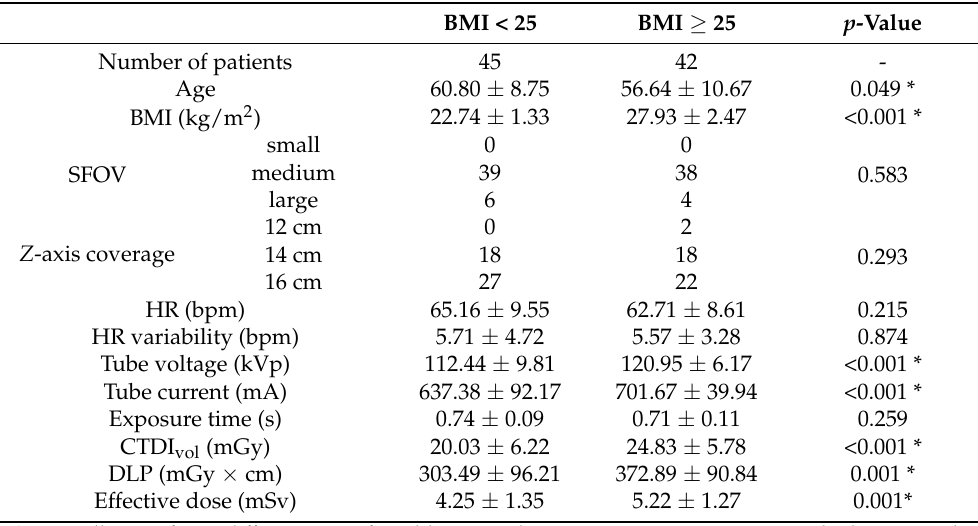
Table 1. Comparison of patient characteristics, scan parameters, and radiation doses between two BMI groups. BMI < 25 BMI ≥ 25 p -Value Number of patients 45 42 - Age 60.80 ±